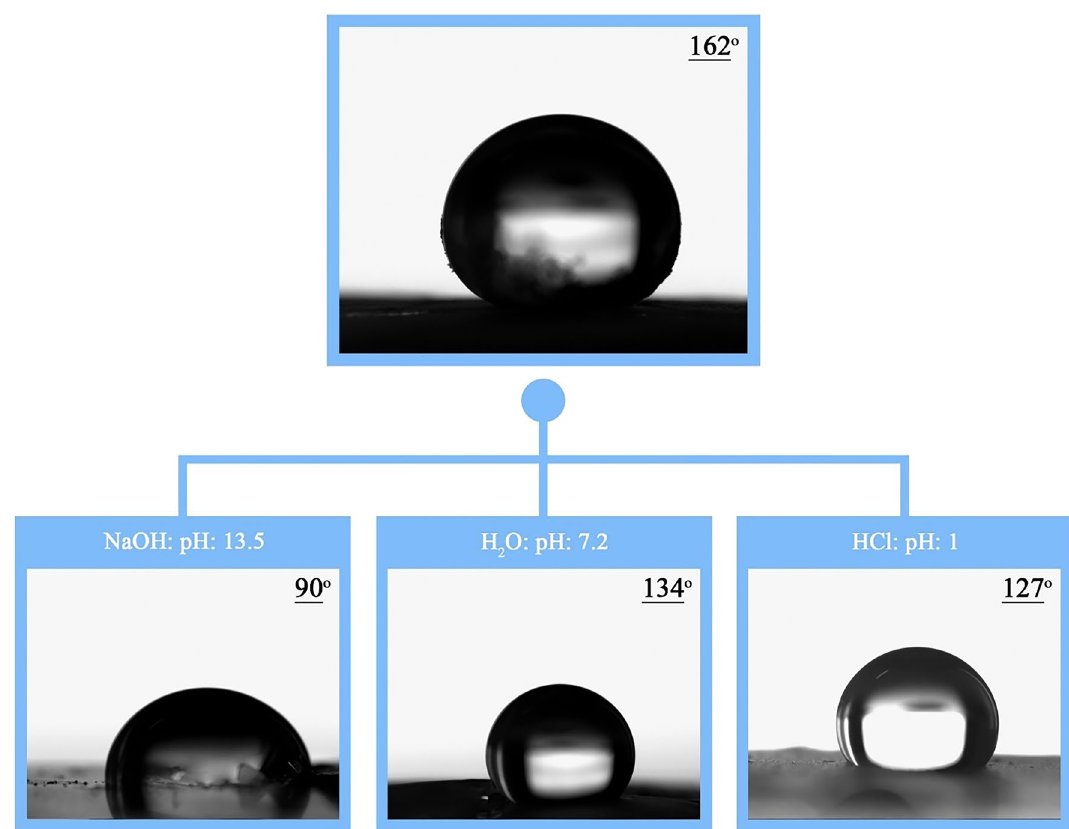
Figure 13. Effect of pH on the contact angle of the optimized